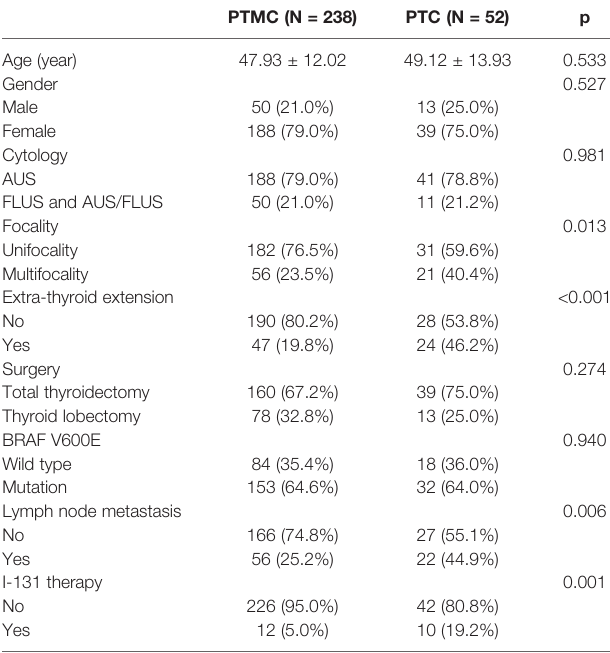
TABLE 2 | The demographic and clinical characteristics of PTC patients by tumor size (n = 290).